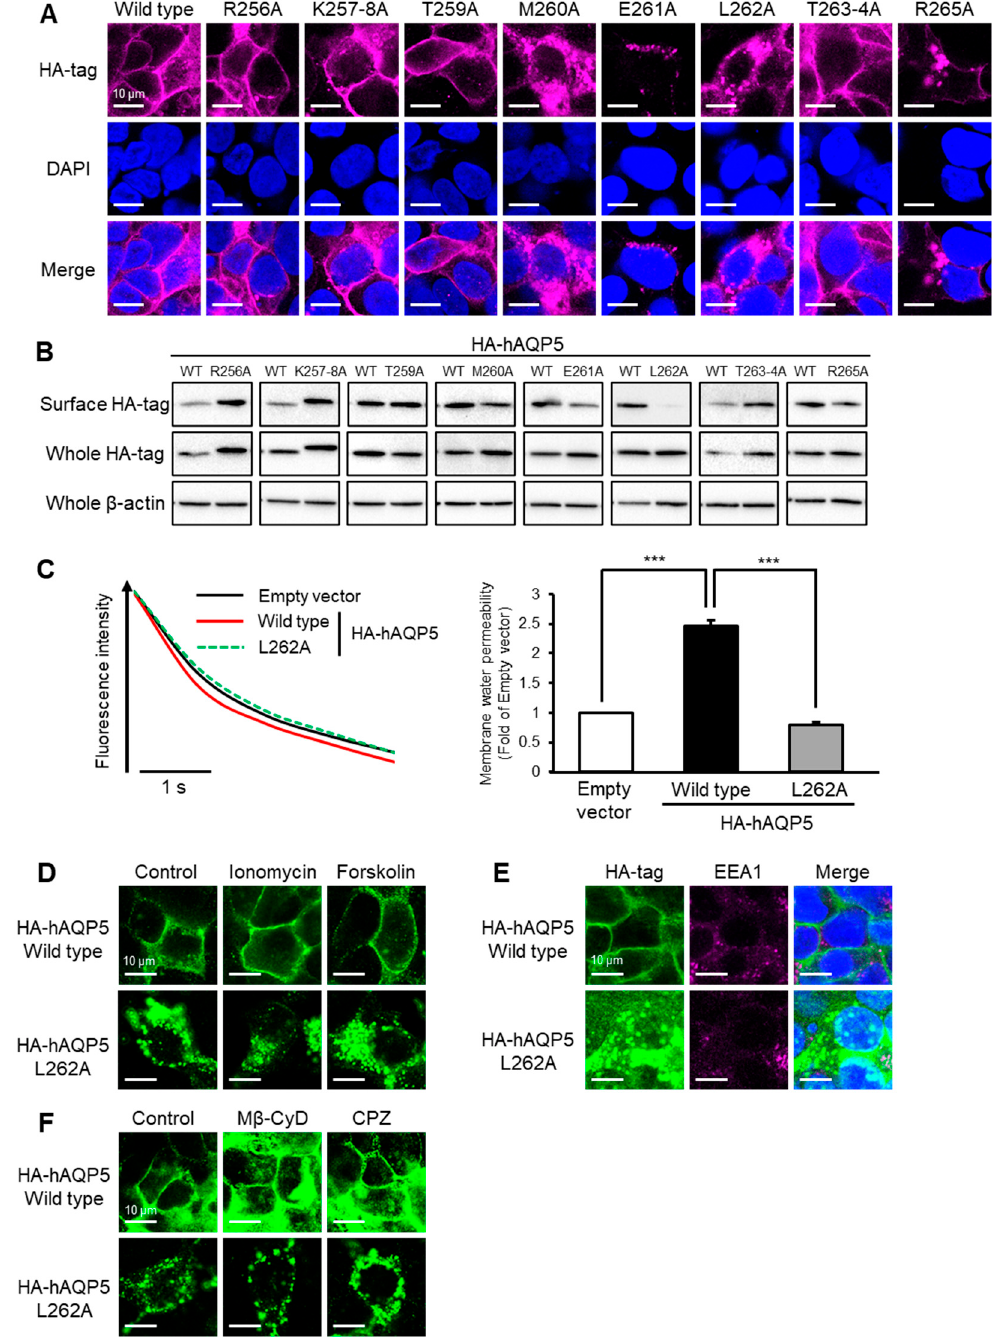
Figure 3. Leu 262 is required for plasma membrane localization of AQP5. HEK-293 cells transfected with hAQP5 C-terminal point mutants were analyzed for the cellular localization of the mutants by immunofluorescence ( A ) and assessed for the level of cell surface mutants by cell surface biotinylation and Western blotting ( B ). Membrane water permeability of CHO-K1 cells transfected with hAQP5 L262A was measured using the calcein quenching method at 37 °C. Each data point represents mean ± SE ( n = 3), *** p < 0.001 ( C ). HEK-293 cells transfected with hAQP5 L262A were treated with ionomycin (1 µM) or forskolin (10 µM) for 15 min. The cellular localization of the mutants was analyzed by immunofluorescence ( D ). HEK-293 cells transfected with hAQP5 L262A were analyzed for the cellular localization of the mutants and EEA1 by immunofluorescence ( E ). HEK-293 cells transfected with hAQP5 L262A were treated with methyl- β -cyclodextrin (M β - CyD, 1 mM) or chlorpromazine (CPZ, 10 µ g/mL) for 12 h. The cellular localization of the mutants was analyzed by immunofluorescence ( F ). Typical data in triplicated experiments are